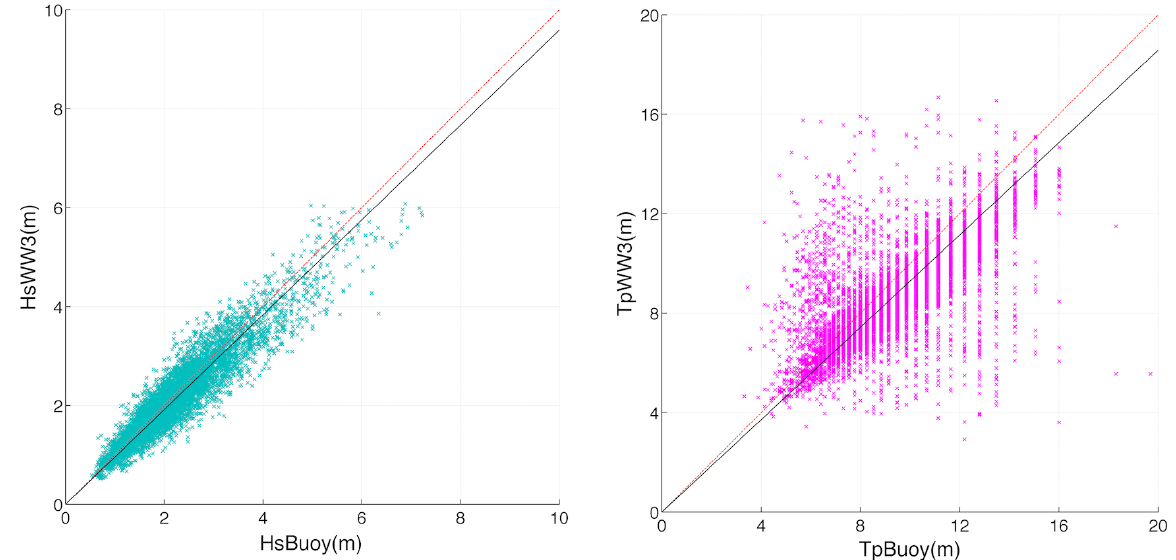
Figure 3. Scatterplot, where each point corresponds to the pair [(parameters) observed (parameter) modeled], the dashed line represents the perfect fit and the continuous line represents the symmetric